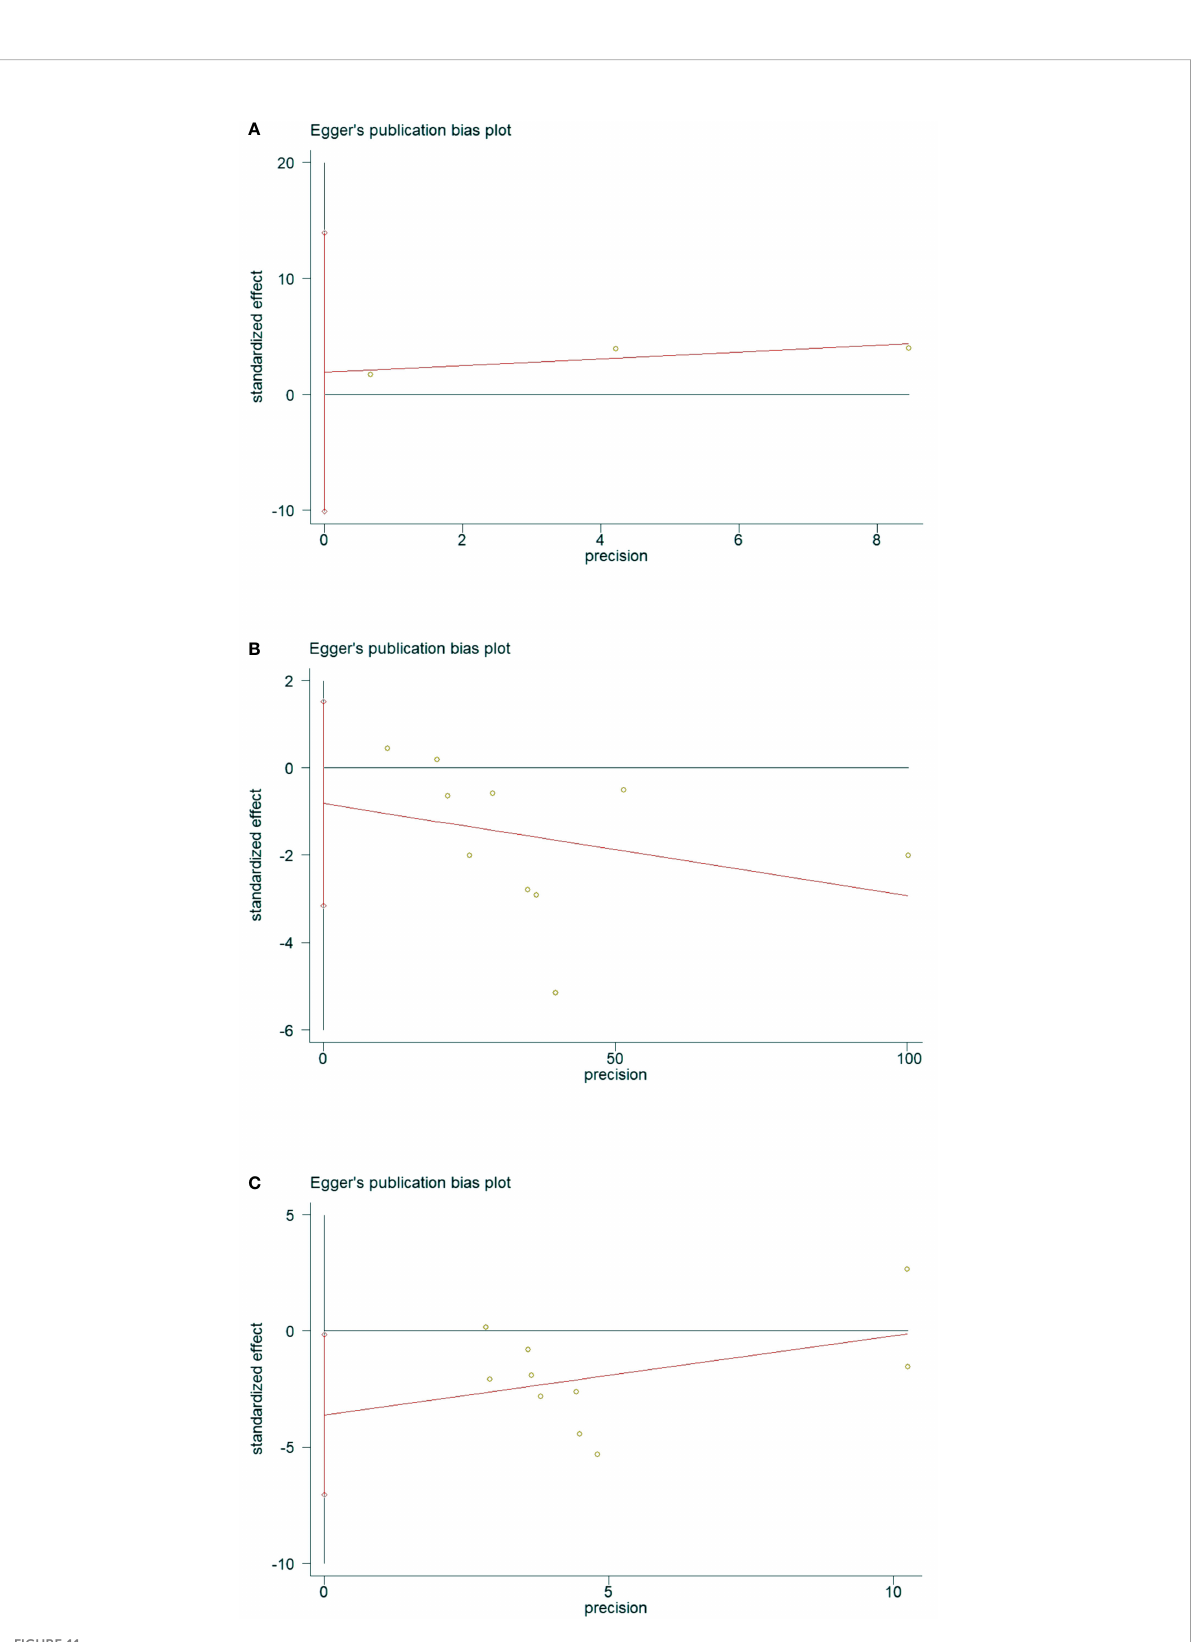
FIGURE 11 Data plot of Egger ’ s test for various studies included in the literature.(Note: (A) Data plot of Egger ’ s test for Osteoporosis incidence. (B) Data plot of Egger ’ s test for lumbar spine BMD. (C) Data plot of Egger ’ s test for lumbar spine